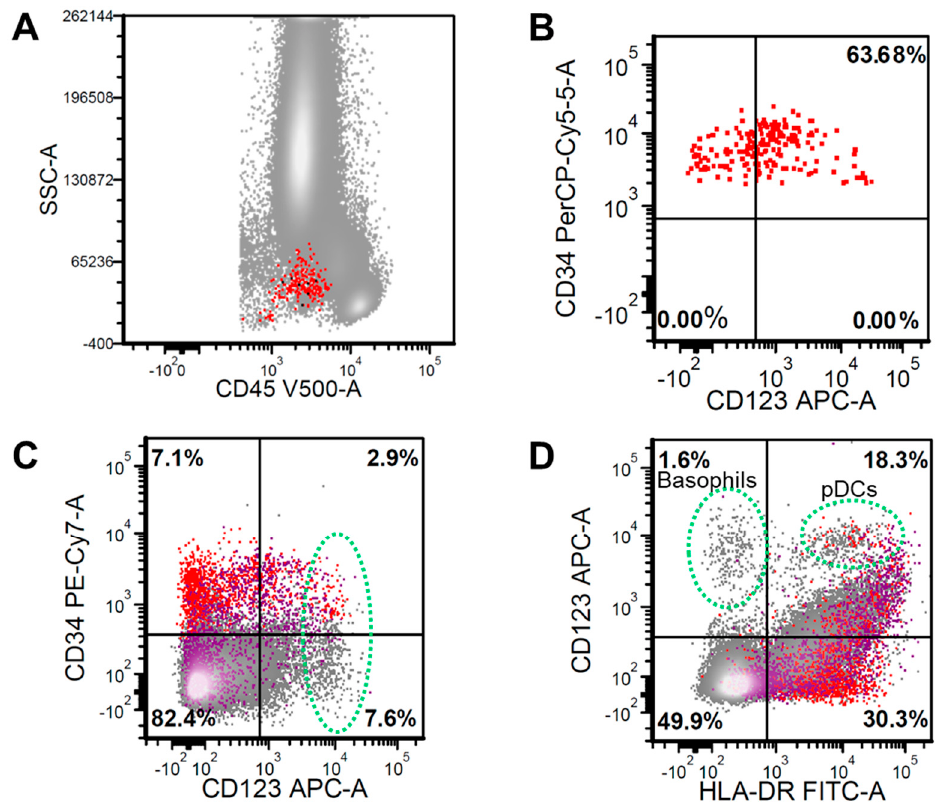
Figure 2. ( A ) Flow cytometry analysis on a bone marrow aspiration sample demonstrating CD34 +/ CD45 dim hematopoietic stem cells (HSC) (red color) ( B ) with normal CD123 expression pattern. ( C ) Combinatorial gating depicts various CD123 bright cells (green oval), which include CD34 + HSC elements and CD34 − populations (gray), with only rare CD117 + cells (purple). ( D ) CD123 bright cells can be further subtyped into basophils (CD123 bright / HLA − DR − ) and plasmacytoid dendritic cells (pDCs) (CD123 bright / HLA − DR + ).